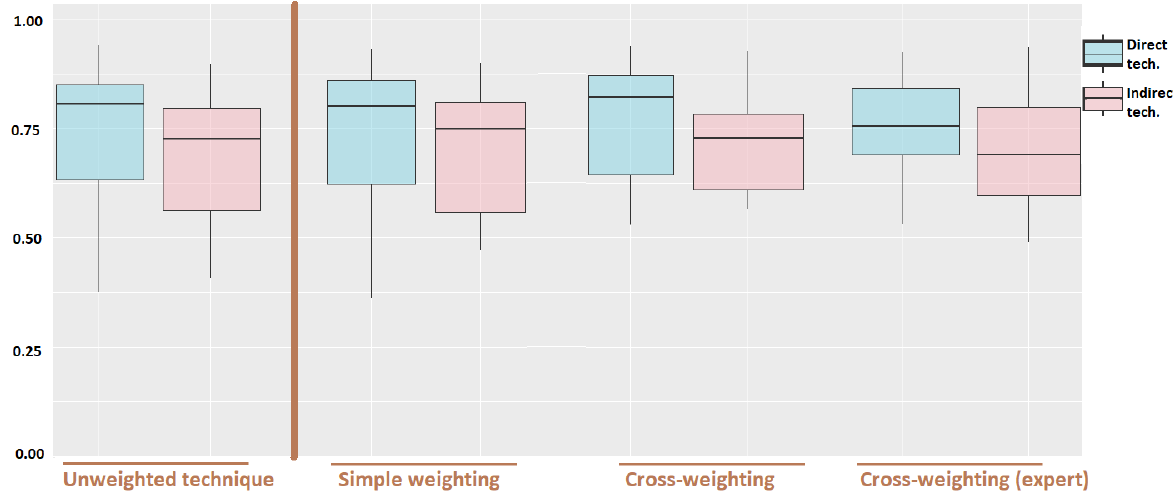
Figure 12. Usability scores distribution—within HMD subjects data.